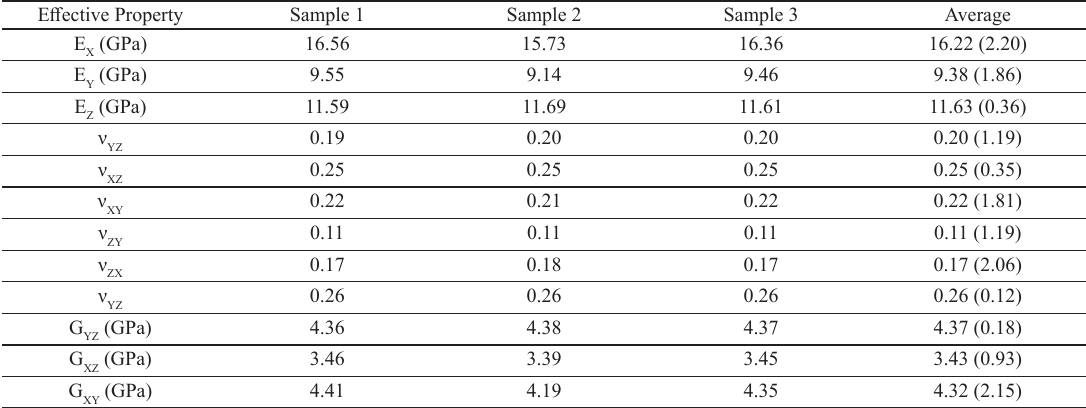
Table 8. Effective elastic properties of samples obtained by two-step homogenization (CoV in parenthesis). Effective